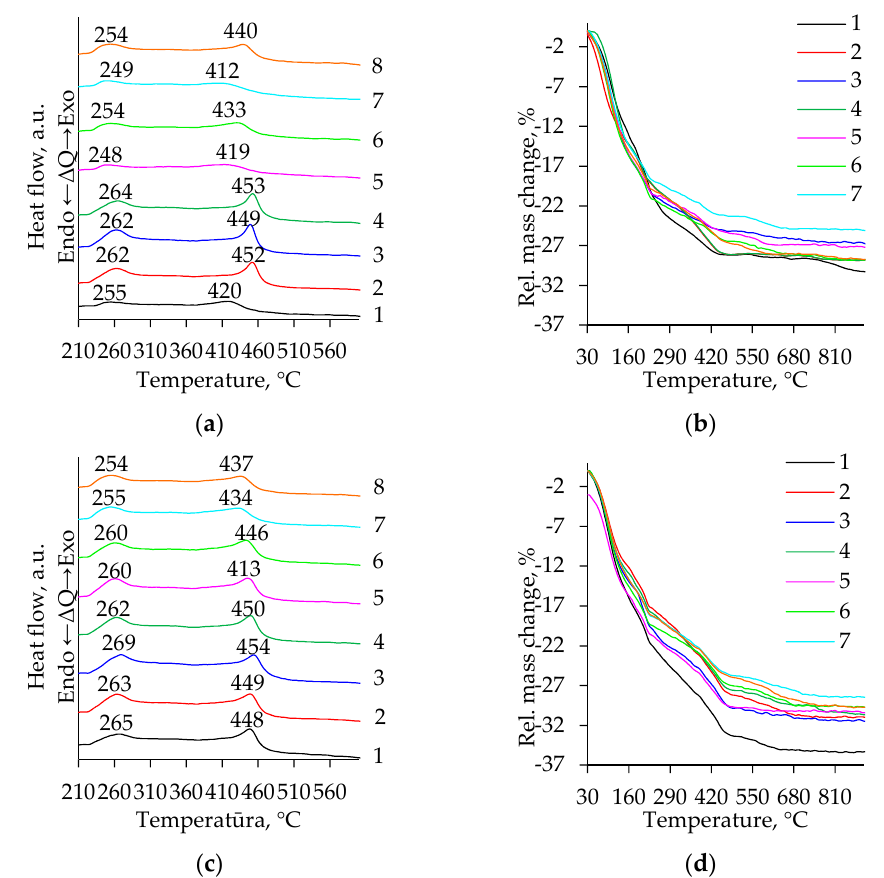
Figure 7. DTA ( a , c ) and TG ( b , d ) curves of the TiO 2 aerogels after subcritical drying (800 mbar, 70 °C, 8 h) vs. precursor type (TIP ( a , b ), TBOT ( c , d )), ageing (without aging (1–4), aged (5–8)), and additional solvent exchanges (1, 5—without exchange; 2, 6—CH; 3, 7—nH; 4, 8—DE). Table 2. Details of STA curves that are typical for TiO 2 aerogel anatase phase formation.